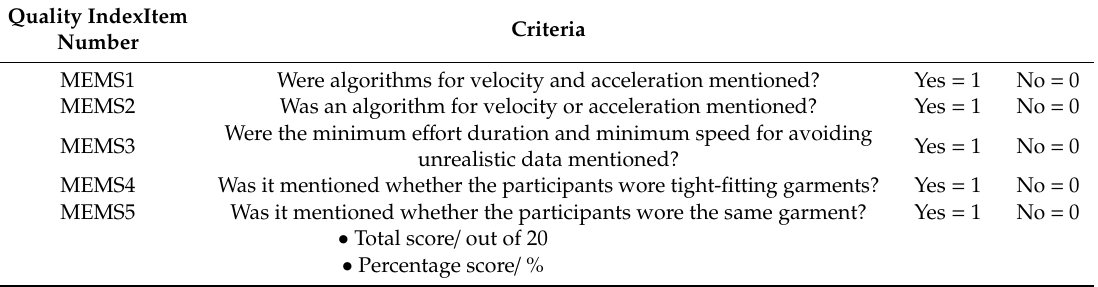
Table 4. Check sheet for assessing external workload or collective variables using MEMS in